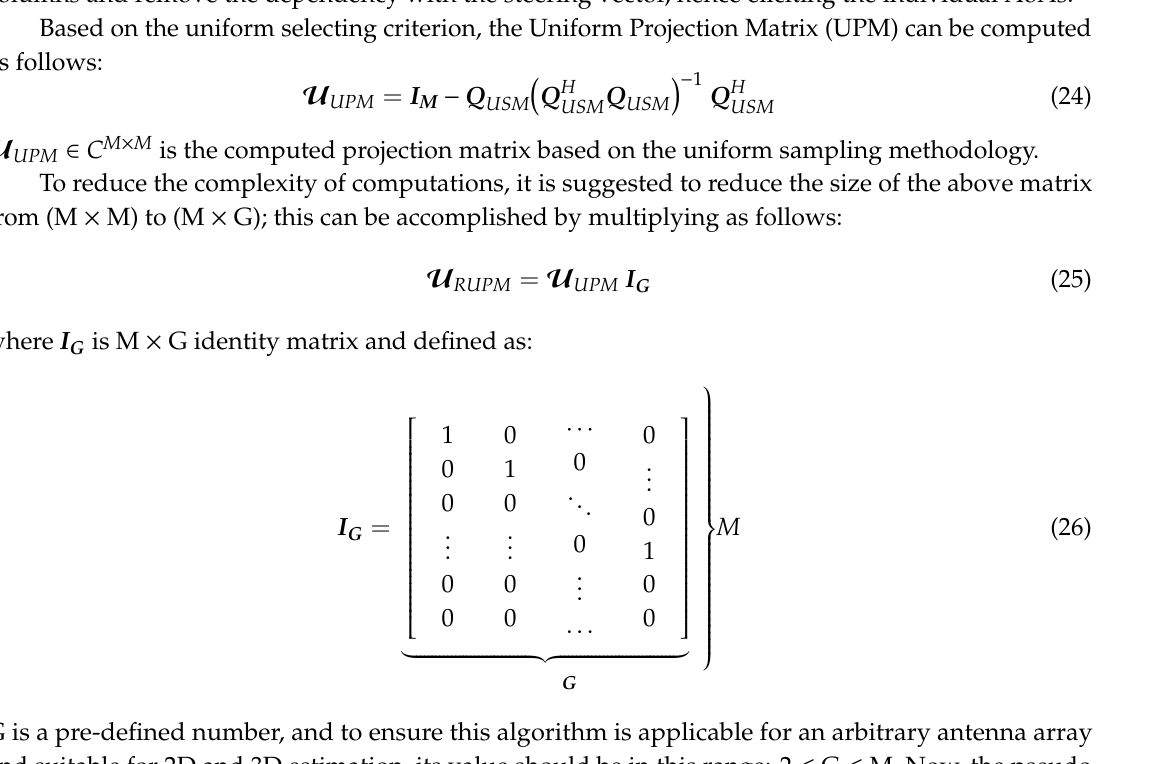
= 9, M = 100 and C = USM with L